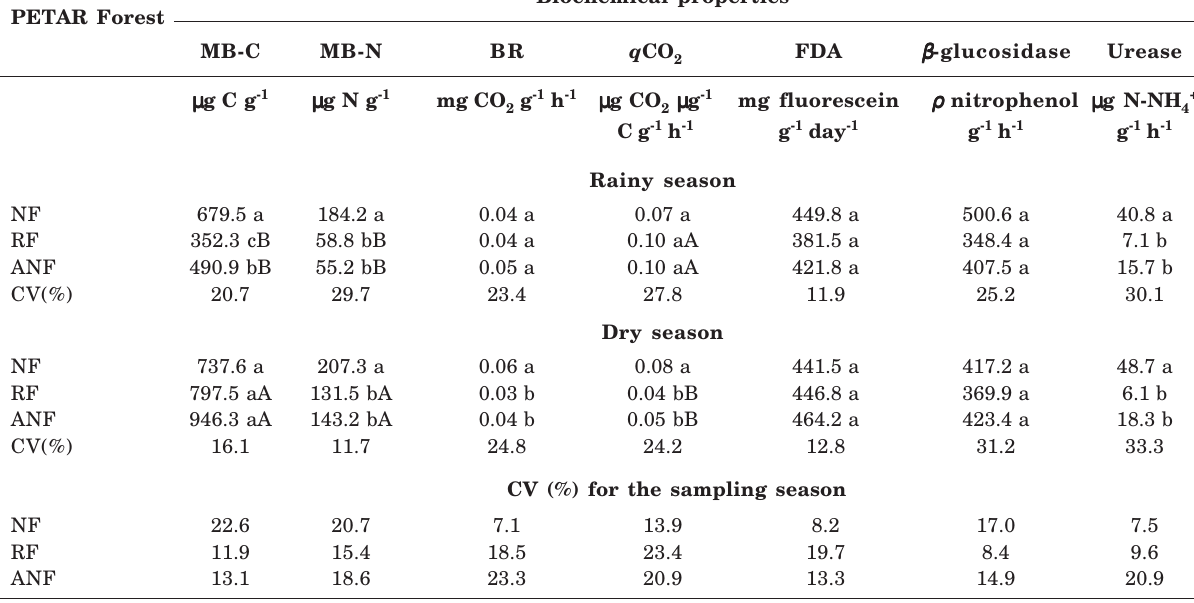
Identical lowercase letters within the same season (dry or rainy) indicate no significant difference between the forests evaluated, according to the Scott-Knott test (5%). Absent uppercase letters within the same forest indicate no significant difference between the seasons evaluated (rainy and dry), according to the Scott-Knott test